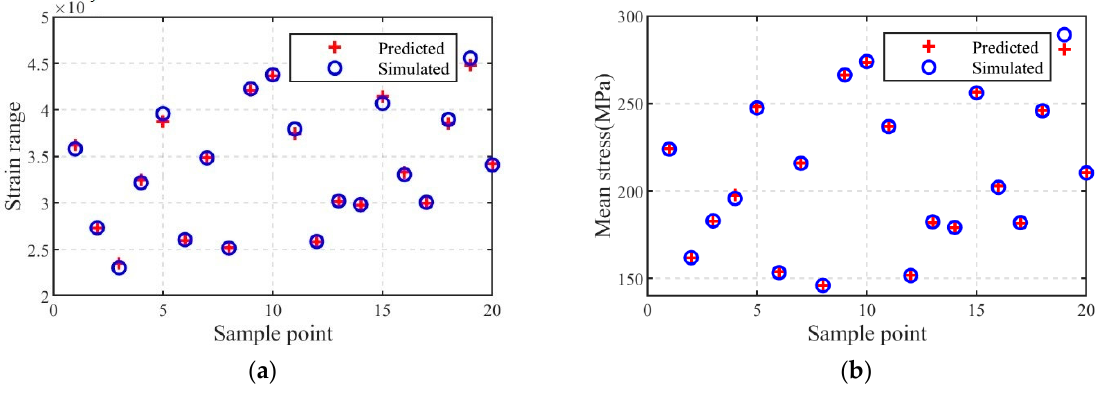
Figure 8. Comparison between predicted values and simulation values: ( a ) strain range; ( b ) mean stress.